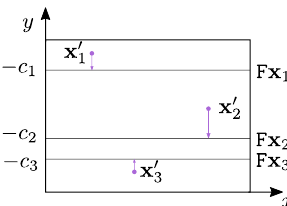
Figure 6: For a tile of size 1000 × 1000 , the epipolar curves are well approximated by parallel lines (see section 3). On this figure the lines are assumed to be horizontal. For each correspondence ( x i , x 0 ) there is a vertical shift between the point x 0 i F x i . The median of all these shifts minimizes the relative epipolar error defined by formula 2.